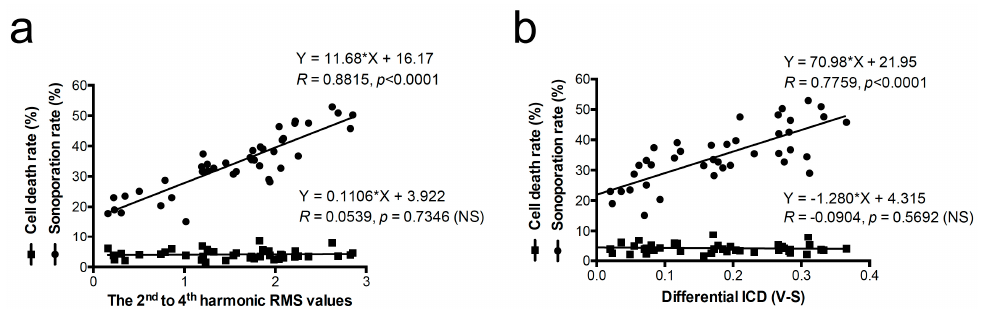
Figure 10. Correlation of the cell death rate and the sonoporation rate versus di ff erential ICD values